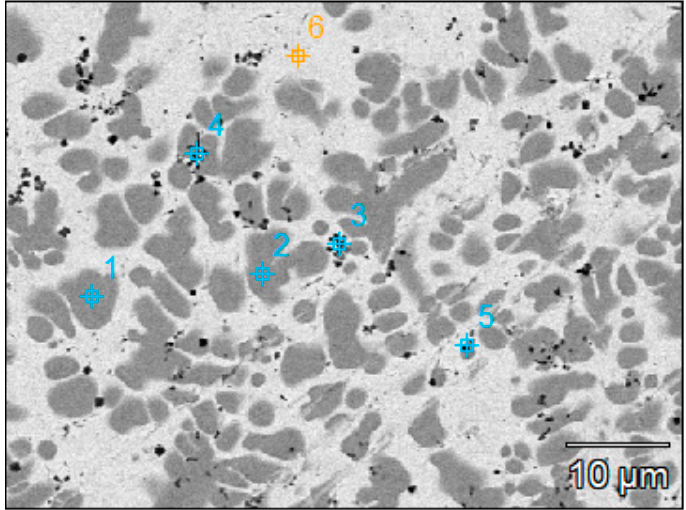
Figure 6. Microstructure of the cross section of the remelted surface layer after CrAl powder laser treatment; the marked points are explained in Table 1; SEM.